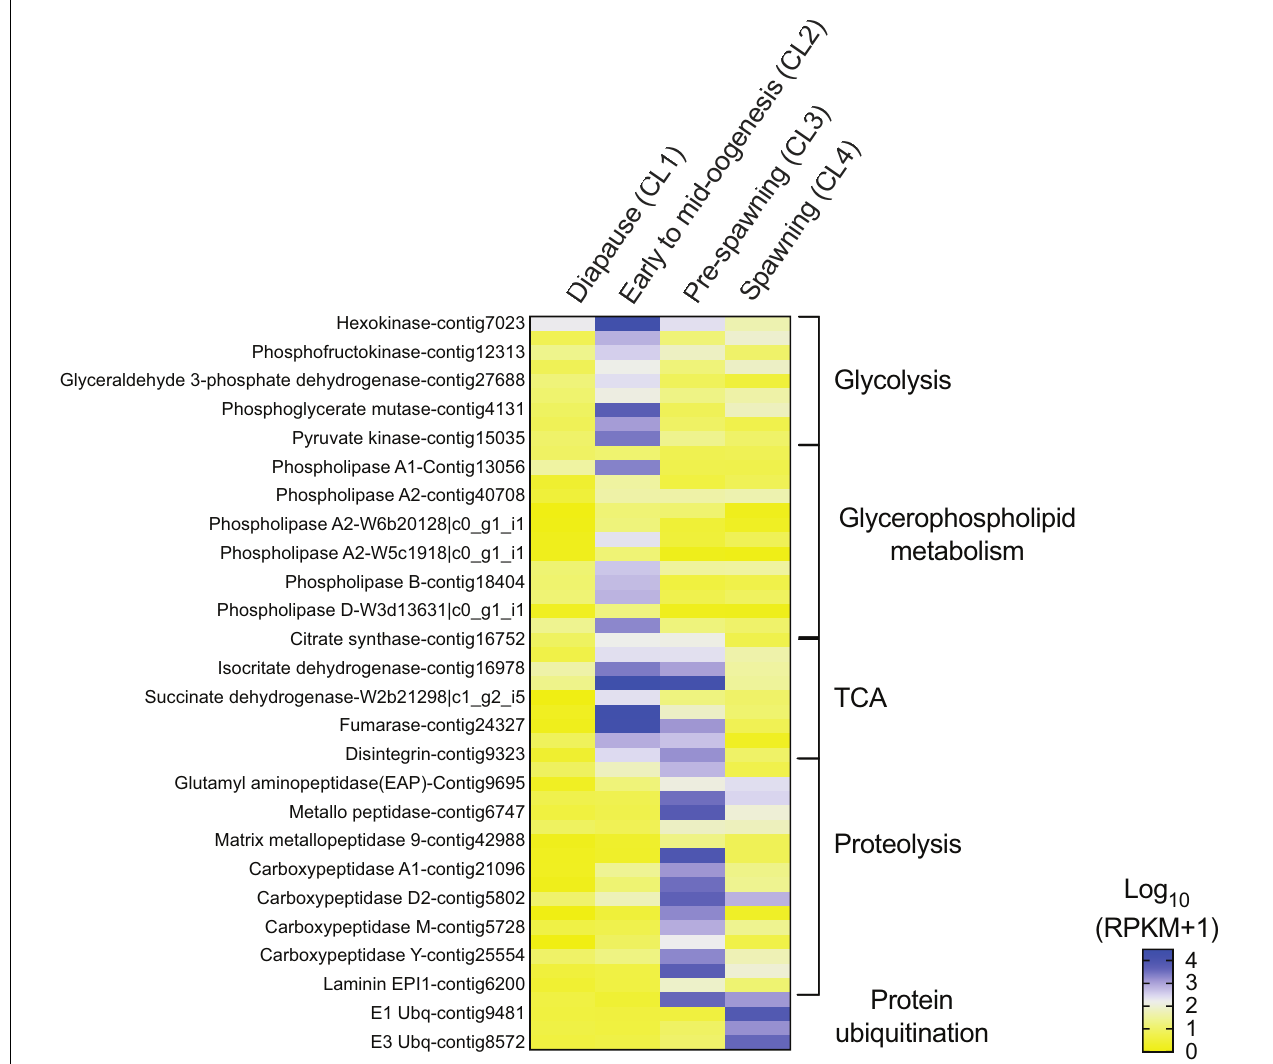
FIGURE 4 | Neocalanus flemingeri relative expression of transcripts involved in energy metabolic process. Heat map of relative expression of target genes associated with energy metabolism involved in the pathways: glycolysis, glycerophospholipid, citric acid cycle (TCA), “proteolysis” [GO:0006508] and “protein ubiquitination” [GO:0016567]. Color-coding for each gene indicates the magnitude of expression as Log 10 (RPKM + 1). Columns are ordered by clusters following the grouping in Figure 1 as indicated by the labels (top). Genes were ordered by functional category (right).